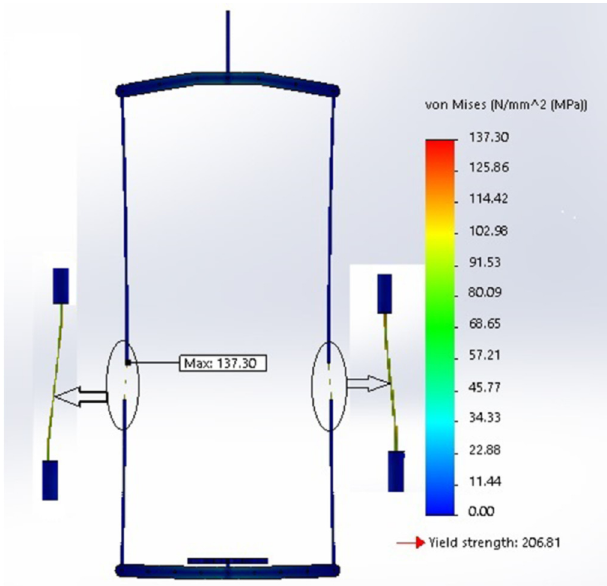
Fig. 6. The Von Misses stress distribution for the developed weighing pan.